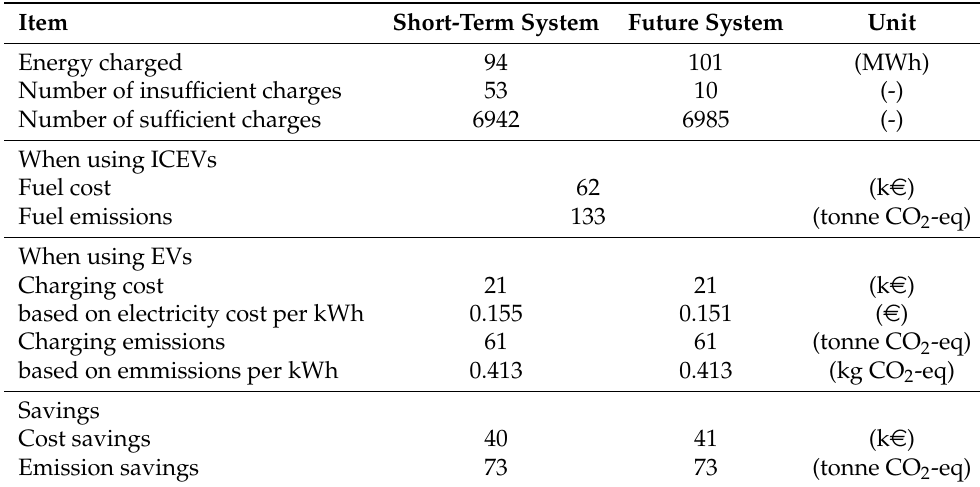
Table 3. Results of simulating one year of business travel for the Apeldoorn location using four dual-connection